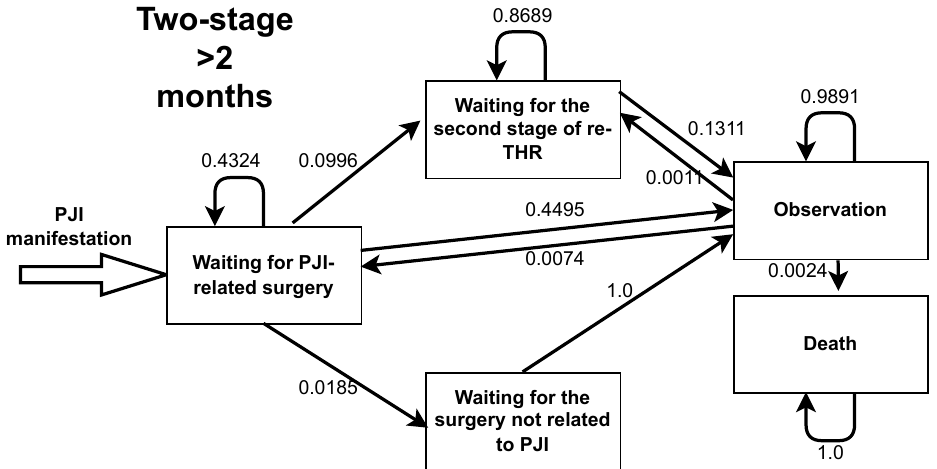
Figure A2. Markov model transition probabilities for two-stage total hip replacement with > 2 months between the stages.